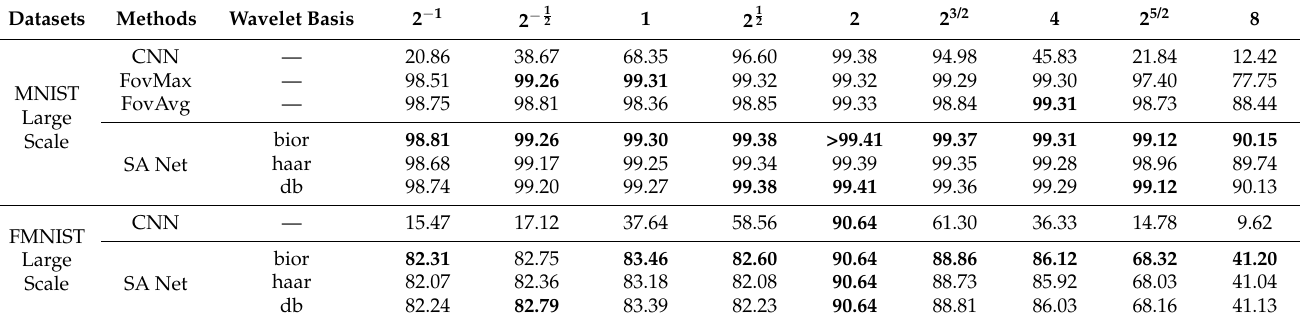
Table 1. Classification accuracy (%) comparison on different scales with different networks.